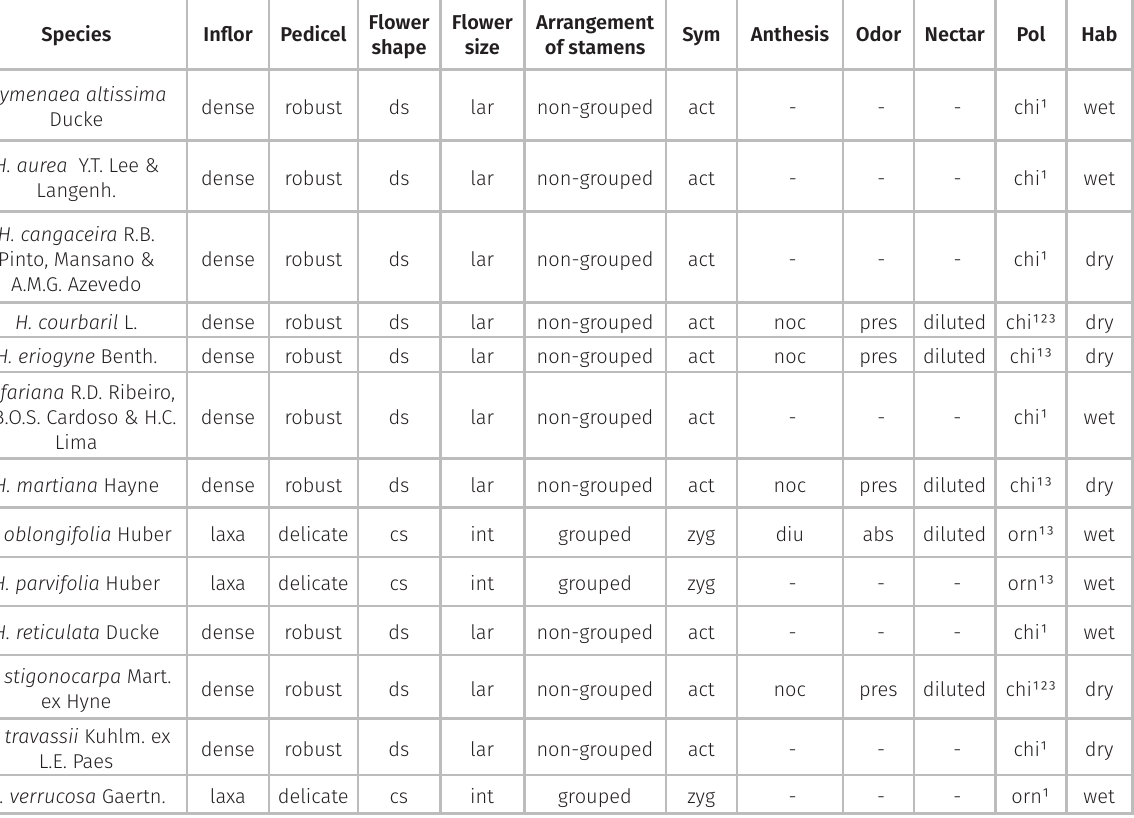
Table III. Inflorescence and floral traits of Hymenaea from herbarium, field data and literature, used to infer about potential pollinators in the reconstruction of character state. Legend: Inflor = inflorescence; ds = dish-shaped; cs = cup-shaped; int = intermediate (10 < int < 20 mm long); lar = large (lar ≥ 20 mm long); Sym = symmetry; act = actinomorphy; szyg = slightly zygomorphy; zyg = zygomorphy; Noc = nocturnal; Diu = diurnal; pres = present; abs = absent; Pol = pollination syndrome; chi = chiropterophily; orn = ornithophily; Hab = habitat; wet = wet forest; dry = dry forest.